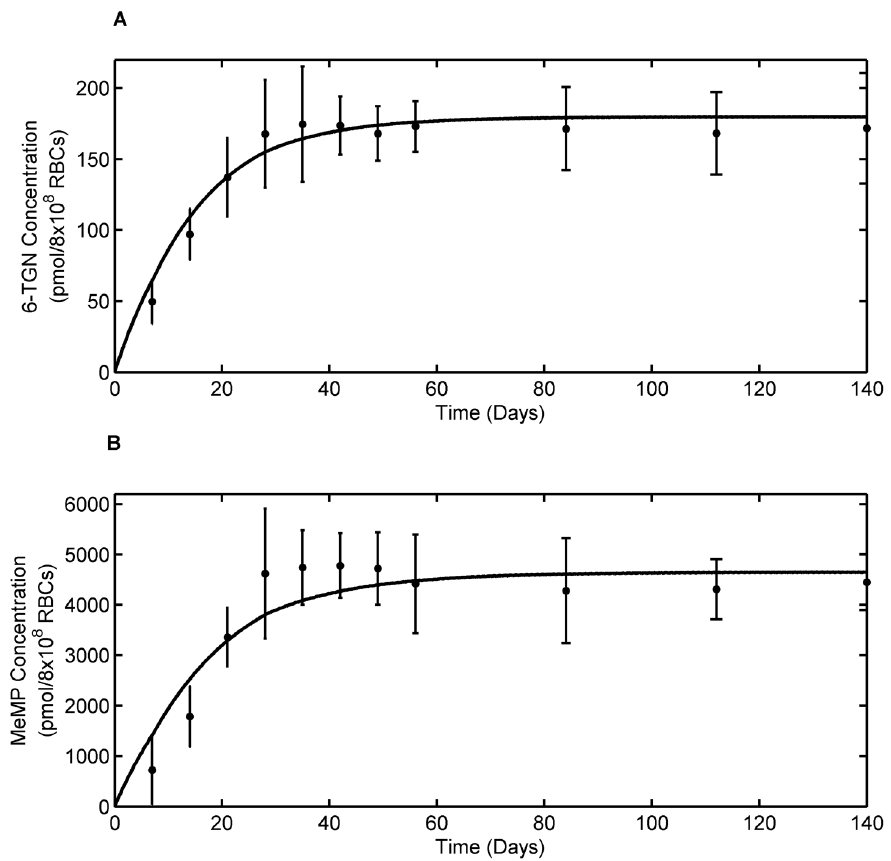
Figure 4. Average patient 6-MP model fit to literature data. A. Model fit to RBC 6-TGN concentration data. B. Model fit to RBC MeMP concentration data. Solid dots represent data points and curves represent 6-MP model (Eqn. 2) fit. Error bars represent standard error.